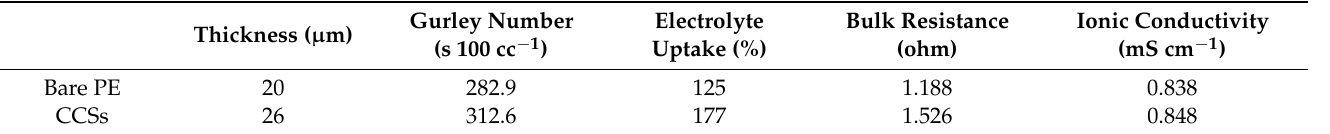
Table 1. Physical properties of bare PE and CCSs.